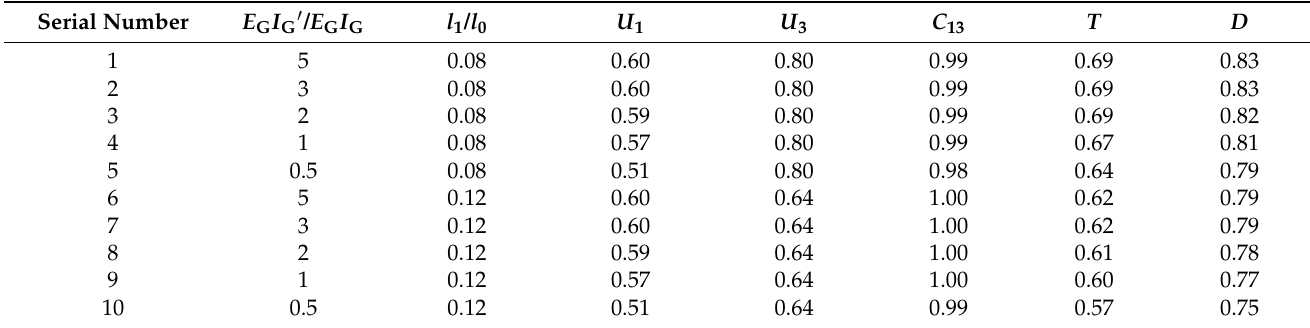
Table 8. Calculation results of coupling coordination between main girder stiffness and uncoupled zone in the span.